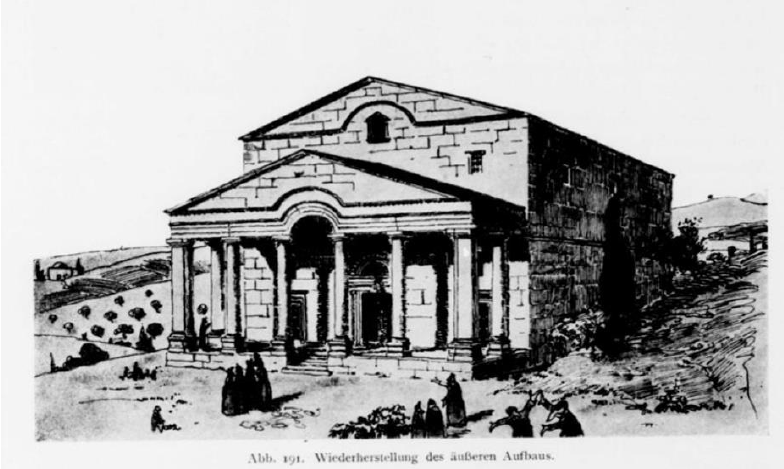
Figure 5. The large synagogue in Kfar Baram, theoretical reconstruction by (Kohl and Watzinger 1916, p. 100).